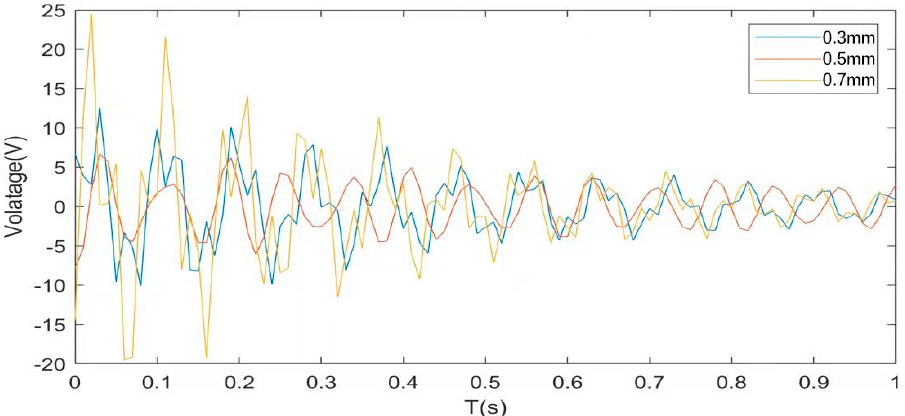
Figure 19. Control the required voltage when the piezoelectric sheet is of different thicknesses.